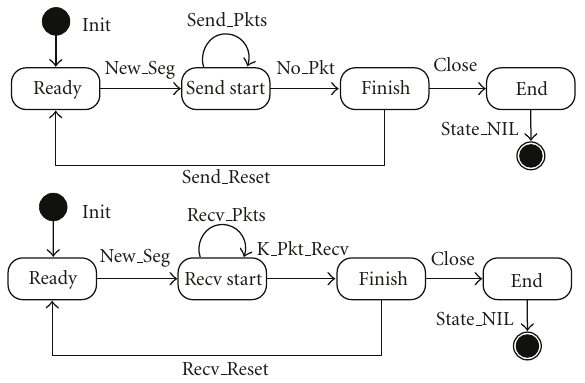
Figure 9: The ADP send/receive finite state machine.